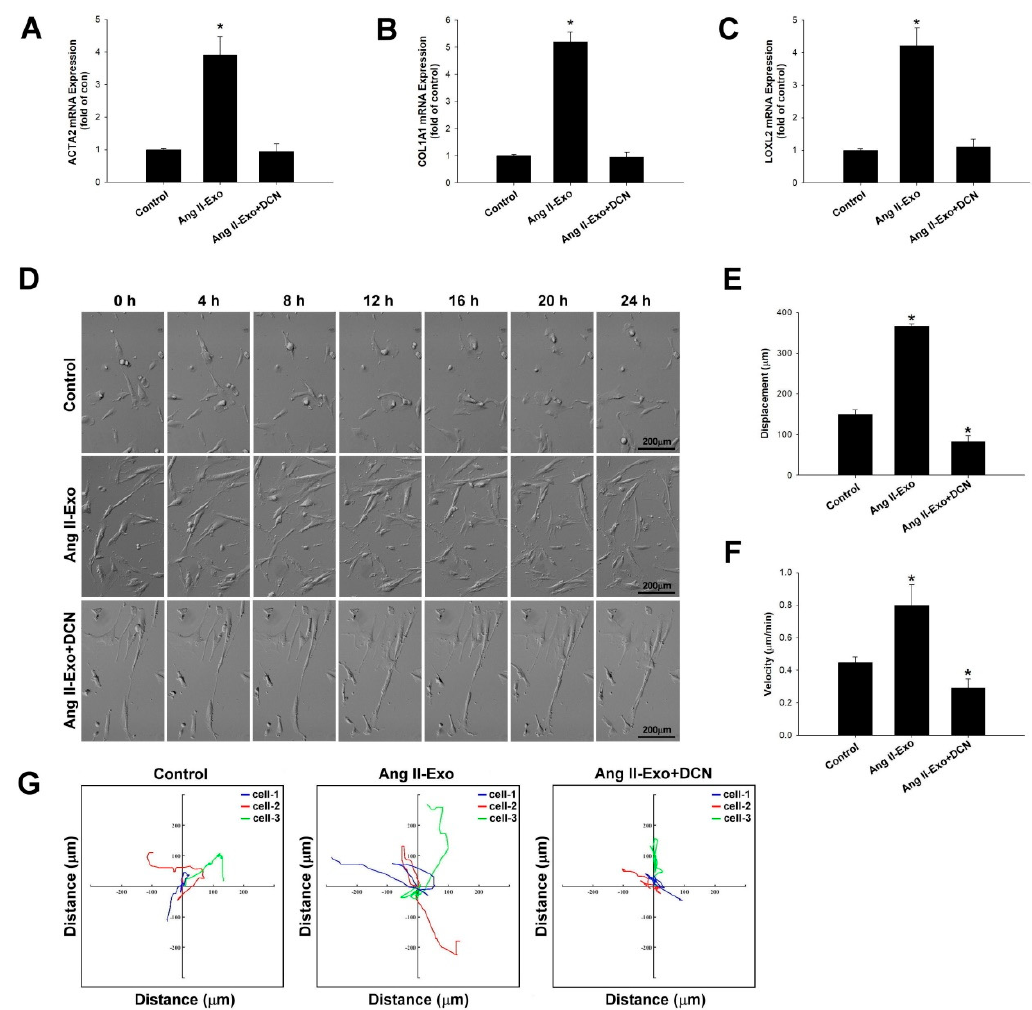
Figure 7. DCN inhibits collagen-associated gene expression, fibroblast transformation, and cell motility in vitro. The e ff ects of DCN on ATCA2 , COL1A1, and LOXL2 expressions were examined using real-time PCR and normalized by β –actin ( A – C ). * p < 0.05 vs. control from three independent experiments. DCN e ff ect on HCF cell migration was examined using time-lapse confocal microscopy. Images were acquired ( D ), and cell movements measured as displacement ( µ m) ( E ), velocity ( µ m / min) ( F ), and motility tracks (x and y axis; distance µ m) ( G ), were plotted. * p < 0.05 vs. control from three independent experiments.